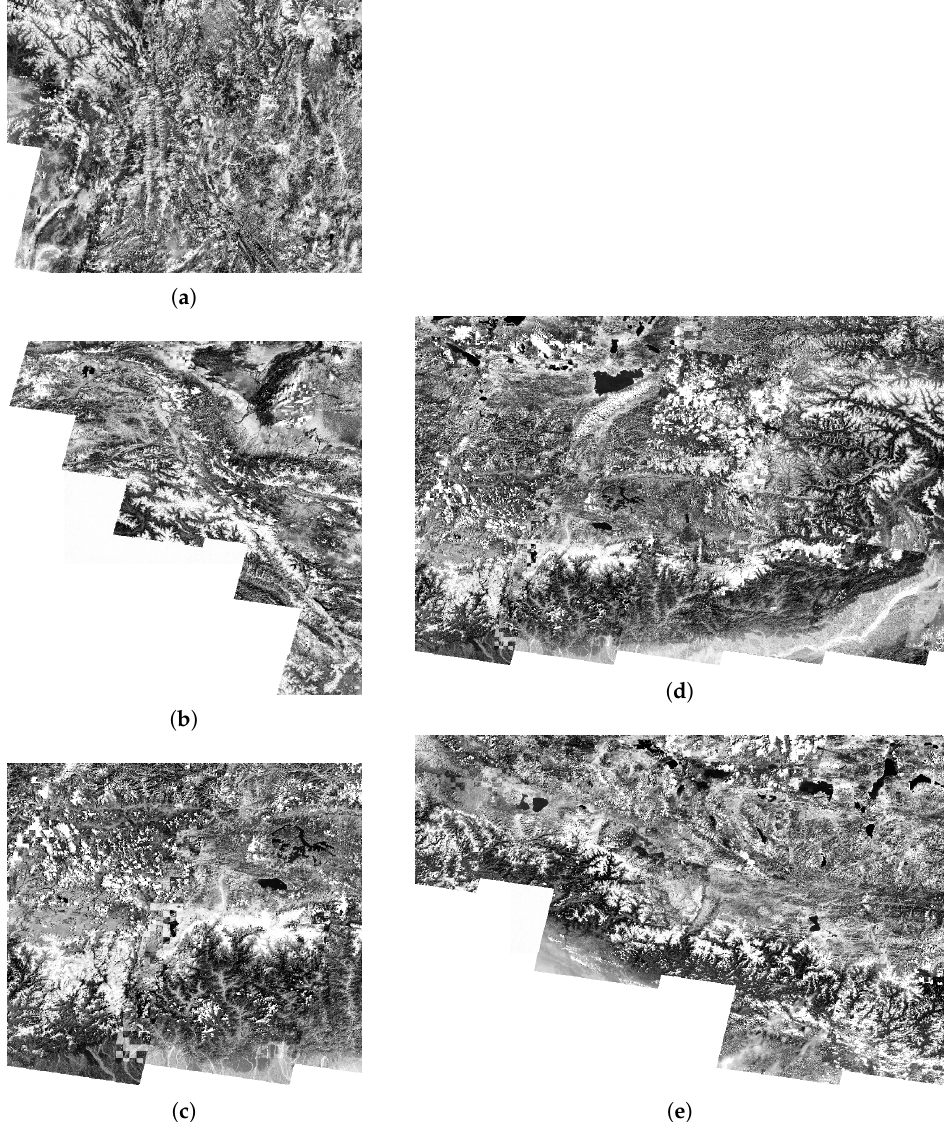
Figure 11. Five zoomed areas in the mosaic result covering the entire area of China. Experimental results show that for our in-memory distributed large-scale mosaicking procedure, simply increasing the number of nodes does not significantly improve the mosaicking speed, but it has a negative